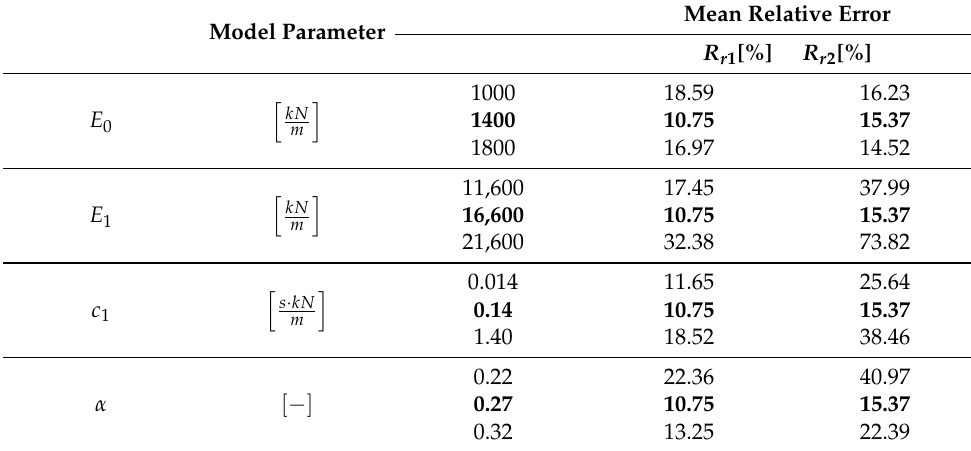
Table 3. Model parameter values selected for additional